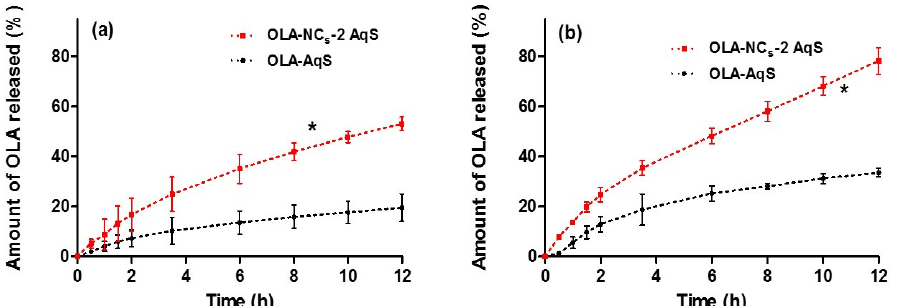
Figure 7. In vitro release of OLA from the aqueous suspensions of lyophilized OLA-NCs-2 and pure OLA in 0.1 N HCl acid (pH 1.2) with 0.5% Soluplus ® ( a ) and in PBS (pH 6.8) with 0.5% Soluplus ® ( b ). Data are represented as mean of three readings with standard deviation (Mean ± SD, n = 3) and “ * ” p < 0.05; OLA-NCs-2 was significant as compared to pure OLA-AqS. At pH 1.2, approximately 19.5% of drug was released at 24 h from pure OLA-AqS, while almost an equal amount of drug (19.0%) was released from the OLA-NCs within 2 h and up to 24 h approximately 53.6% of the drug was released from OLA-NCs (Figure 7a). At pH 6.8, approximately 35.8% of OLA was released at 24 h from pure OLA-AqS, while an equivalent amount of drug (35.5%) was released from the OLA-NCs within 3.5 h and up to 24 h approximately 86.5% of the drug was released from the NCs (Figure 7b). From the saturation solubility study, we found that the OLA exhibited a typical pH- dependent solubility which was relatively higher at pH 6.8 (38.3–69.3 µg·mL − 1 ) and lower at pH 1.2 (23.5–50.6 µg·mL − 1 ). The release profile of OLA was consistent and in agreement with the solubility profiles, where release of drug from NCs was higher (86.4 ± 5.7%) till 24 h at pH 6.8 (simulating the intestinal fluid pH) and relatively lower (53.6 ± 2.3%) during the same duration at pH 1.2 (simulating the gastric fluid pH).. The reason for higher re- lease of OLA at pH 6.8 might be the abundance of buffer species of the release media (PBS) which influenced the solubility of the drug and subsequently the percentage of drug re- leased by making OLA salts of high solubility. Furthermore, the solubility and release of OLA was increased due to the increased ionic concentrations while at low buffer capacity (pH 1.2) a decrease in the solubility and release rate was observed [64].